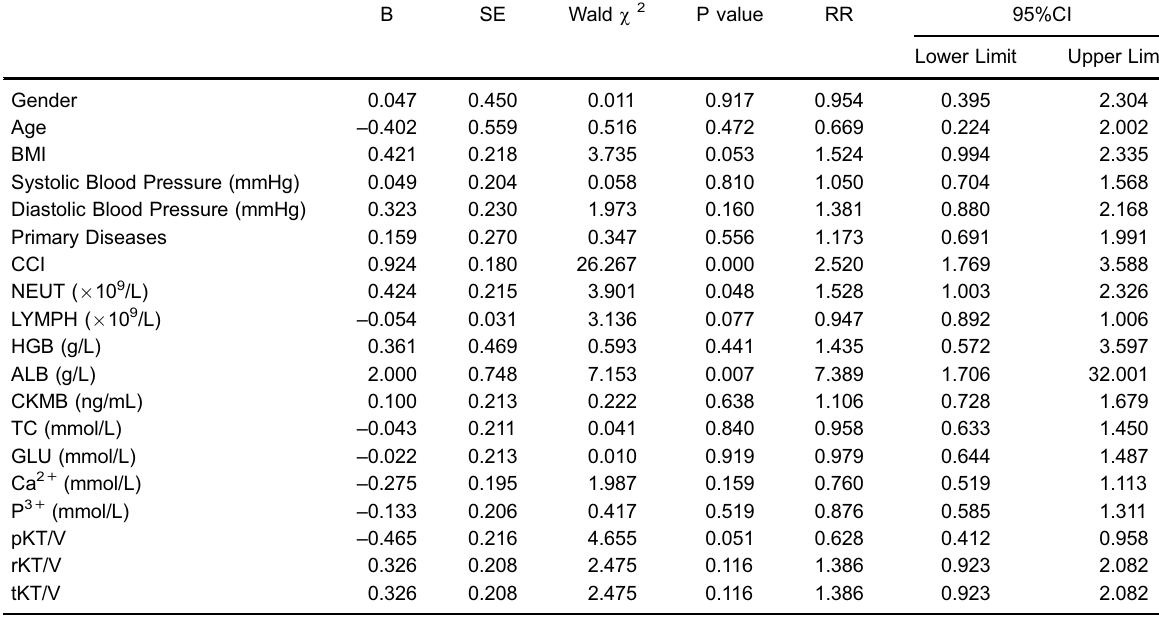
Table 2. Univariate COX regression analysis of survival-related factors in early-start peritoneal dialysis